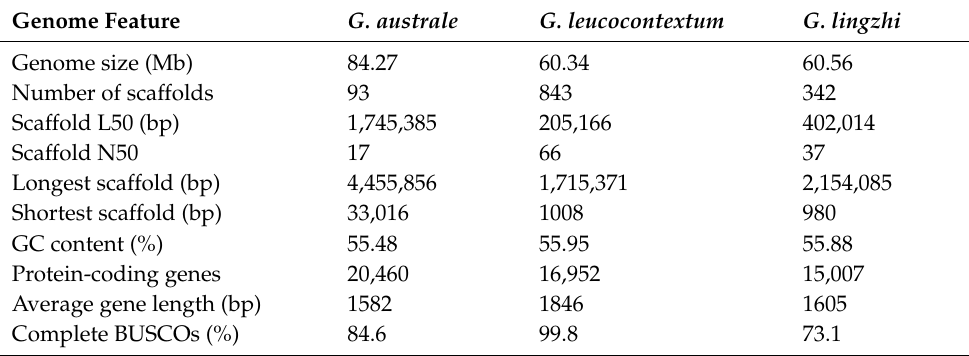
Table 2. Genome features of the three newly sequenced Ganoderma